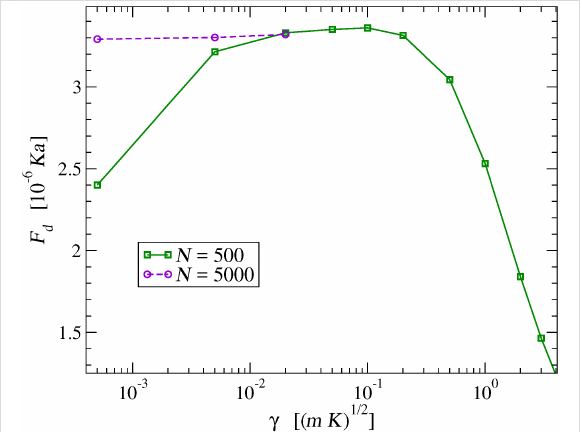
Figure 4: The dynamical friction force as a function of the damping coefficient γ that fixes the (unphysical) dissipation rate of the chain atoms. This is evaluated for v SL = 0.1 v s with protocol A (but protocol B provides identical data). Squares: simulations executed in a standard supercell of size L = 500 a , with 500 atoms. Circles: similar simulations executed in a 10× longer supercell with 5000 atoms, where the waves emitted by the slider have a much longer space to decay fully before coming back to the contact point, even for smaller γ